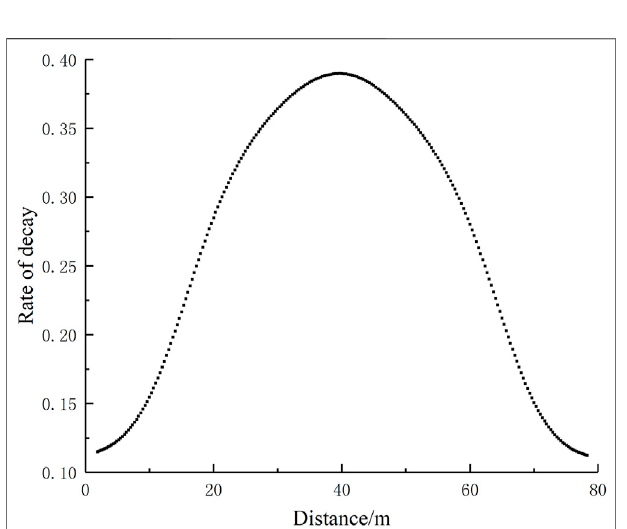
TABLE 6 | Statistical table of attenuation rate of peak overpressure per 10 m in return airway. Name of